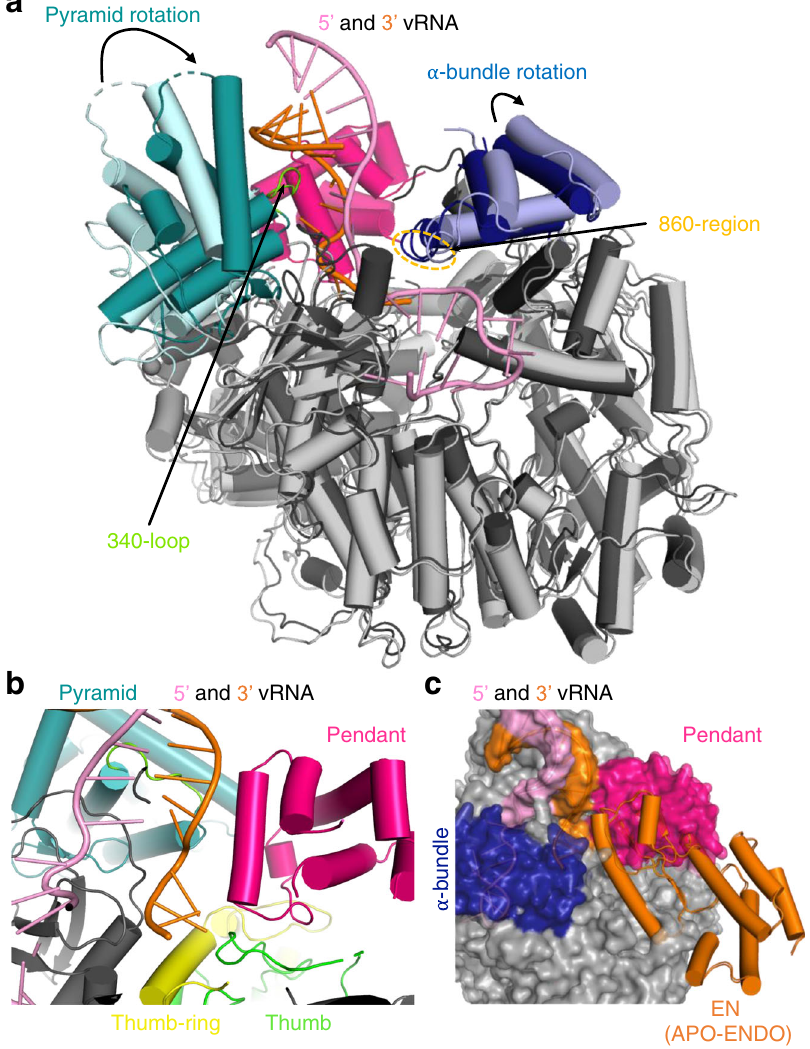
Fig. 6 Global rearrangements upon promoter binding. a PRE-INITIATION (dark grey, teal, dark blue, hot pink) and APO-RIBBON (light grey, light cyan, light blue) structures are superimposed. The pyramid and α -bundle rotations between apo- and promoter-bound structures are indicated as well as the 340-loop and the 860-region. Promoter RNA is shown in pink and orange. b Close-up of the interaction site between promoter RNA (pink and orange) and the pendant (hot pink), thumb-ring (yellow) and thumb (green) domains in the PRE-INITIATION structure. The pyramid domain is shown in teal. c Superposition of the PRE-INITIATION and APO-ENDO structures. PRE-INITIATION is presented as a transparent surface in grey with the pendant (hot pink) and α -bundle (blue) as well as the 5 ′ (pink) and 3 ′ (orange) vRNA highlighted in colour. The EN domain of the APO-ENDO structure is shown as an orange ribbon, which overlaps with the pendant domain volume of the PRE-INITIATION